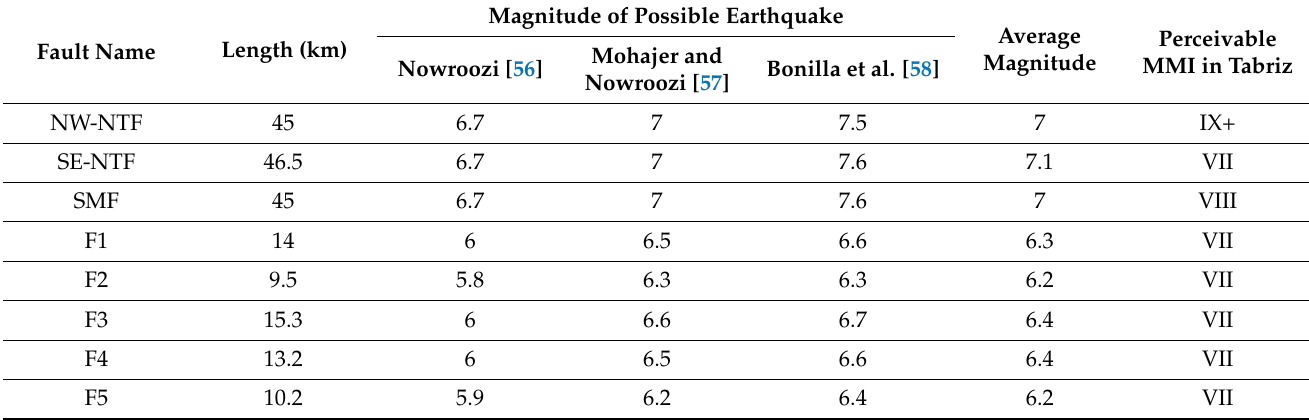
Table 1. Seismic parameters of the faults found in the study area (see Figure 2 for their